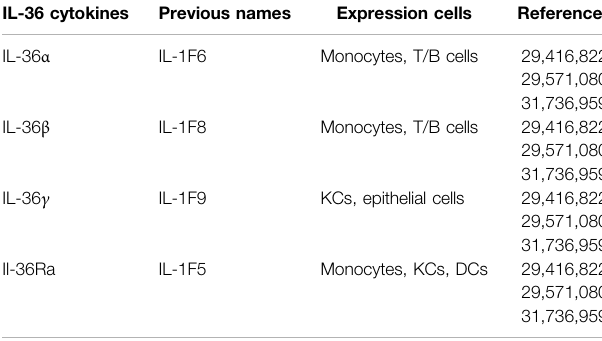
TABLE 1 | Overview of the IL-36